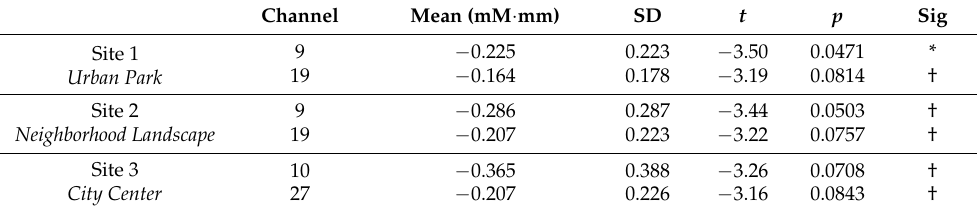
Table 2. Channels showing marginally significant and significant difference in oxy-Hb signals in contrast with baseline